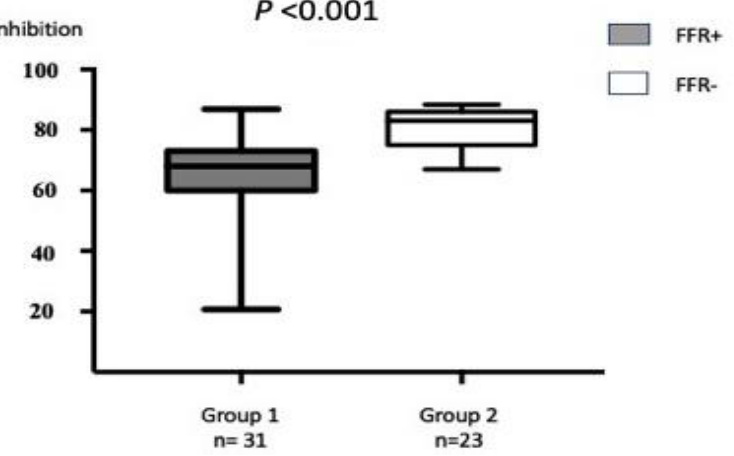
Figure 4. Comparative expression of soluble A 2A R in the plasma from patients FFR+ and FFR − . The results from the inhibition ELISA are expressed in % I (see Methods). In this test, the more A 2A R that was present in the sample indicated a higher % I. FFR < 0.8 (FFR+) patients had a lower % I than FFR − (FFR > 0.8) patients, which indicated that they expressed less A 2A R than the other patients. The results obtained in the two groups were significantly different ( p < 0.001).